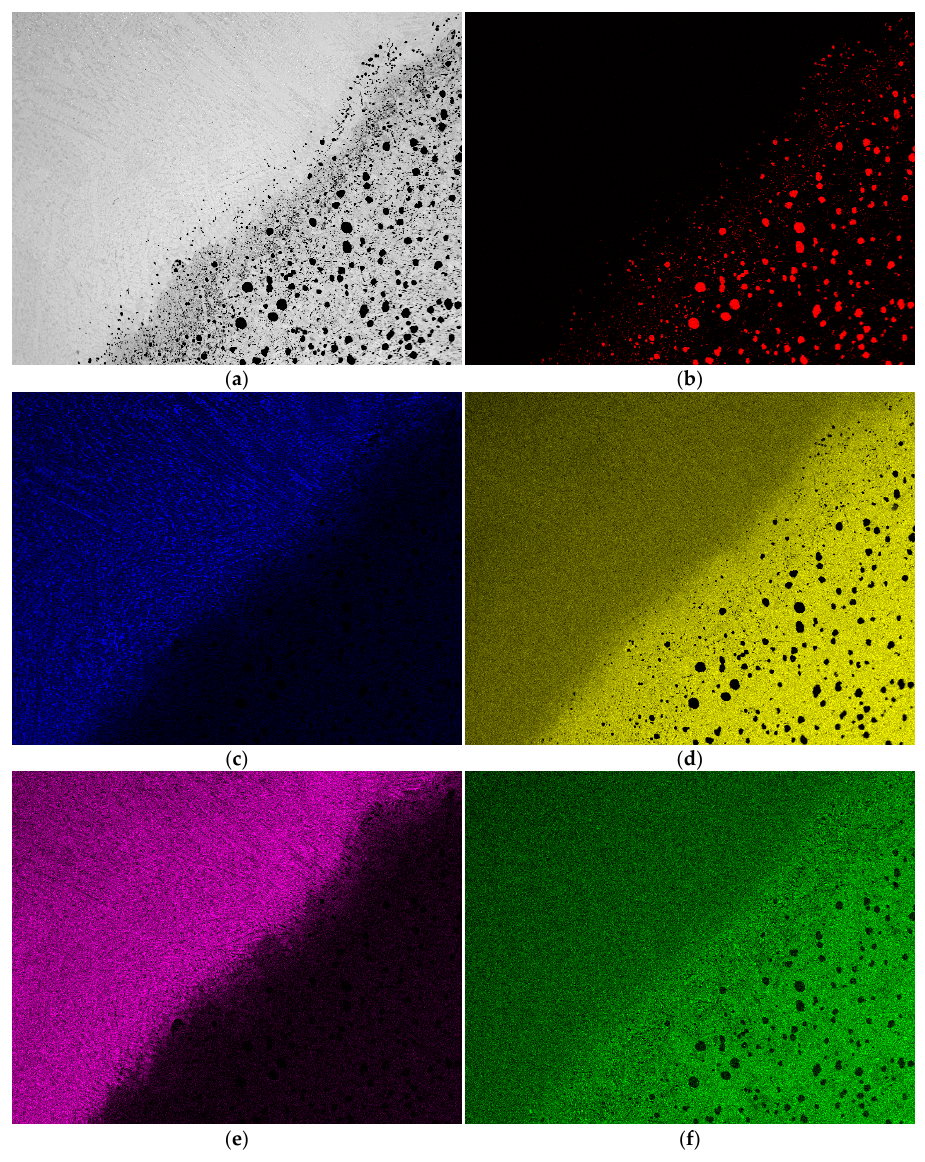
Figure 5. Element surface mapping at 200× magnification of sample 7_P0_P0_W_P700 (UTS = 434.7 MPa); ( a ) overview of mapped area; ( b ) carbon map; ( c ) chromium map; ( d ) iron map; ( e ) nickel map; ( f ) silicon map.